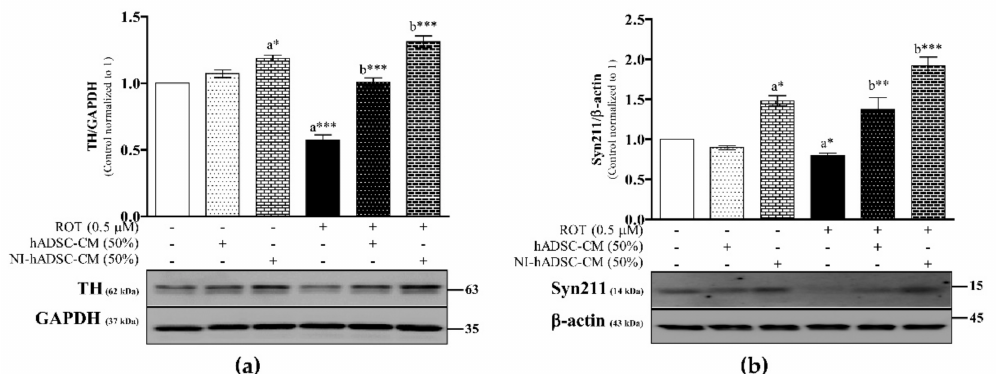
Figure 2. Effects of NI-hADSC-CM against ROT on TH and Syn211 protein expressions. SH-SY5Y cells were seeded at a density of 5 × 10 4 cells/mL in DMEM containing 1% FBS and used for the experiments after overnight incubation. Cells incubated in the absence or presence of ROT (0.5 µ M) for 48 h were treated with hADSC-CM (50%) or NI-hADSC-CM (50%) during the last 24 h, and the TH ( a ), Syn211 ( b ), and GAPDH or β -actin expression levels were assessed by Western blotting. Images are representative of three independent experiments. Data are presented as the mean ± SEM of three independent experiments. Statistical analysis was performed using one-way analysis of variance (ANOVA) followed by Tukey’s post hoc test. Statistical significance: a—compared with control; b—compared with ROT; * p < 0.05, ** p < 0.01, and *** p <